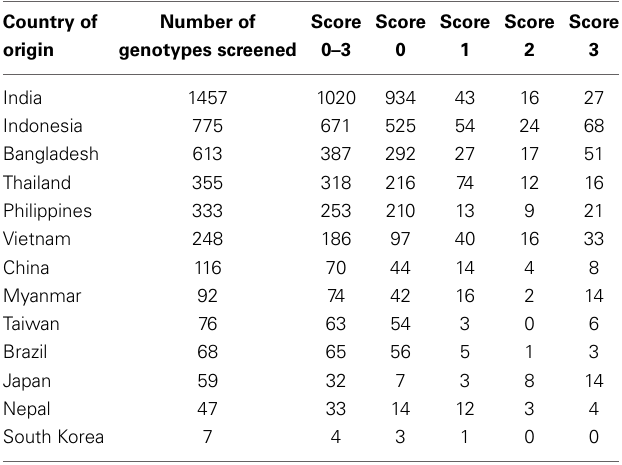
Table 1 | Summary of rice genotypes screened as resistant in uniform blast